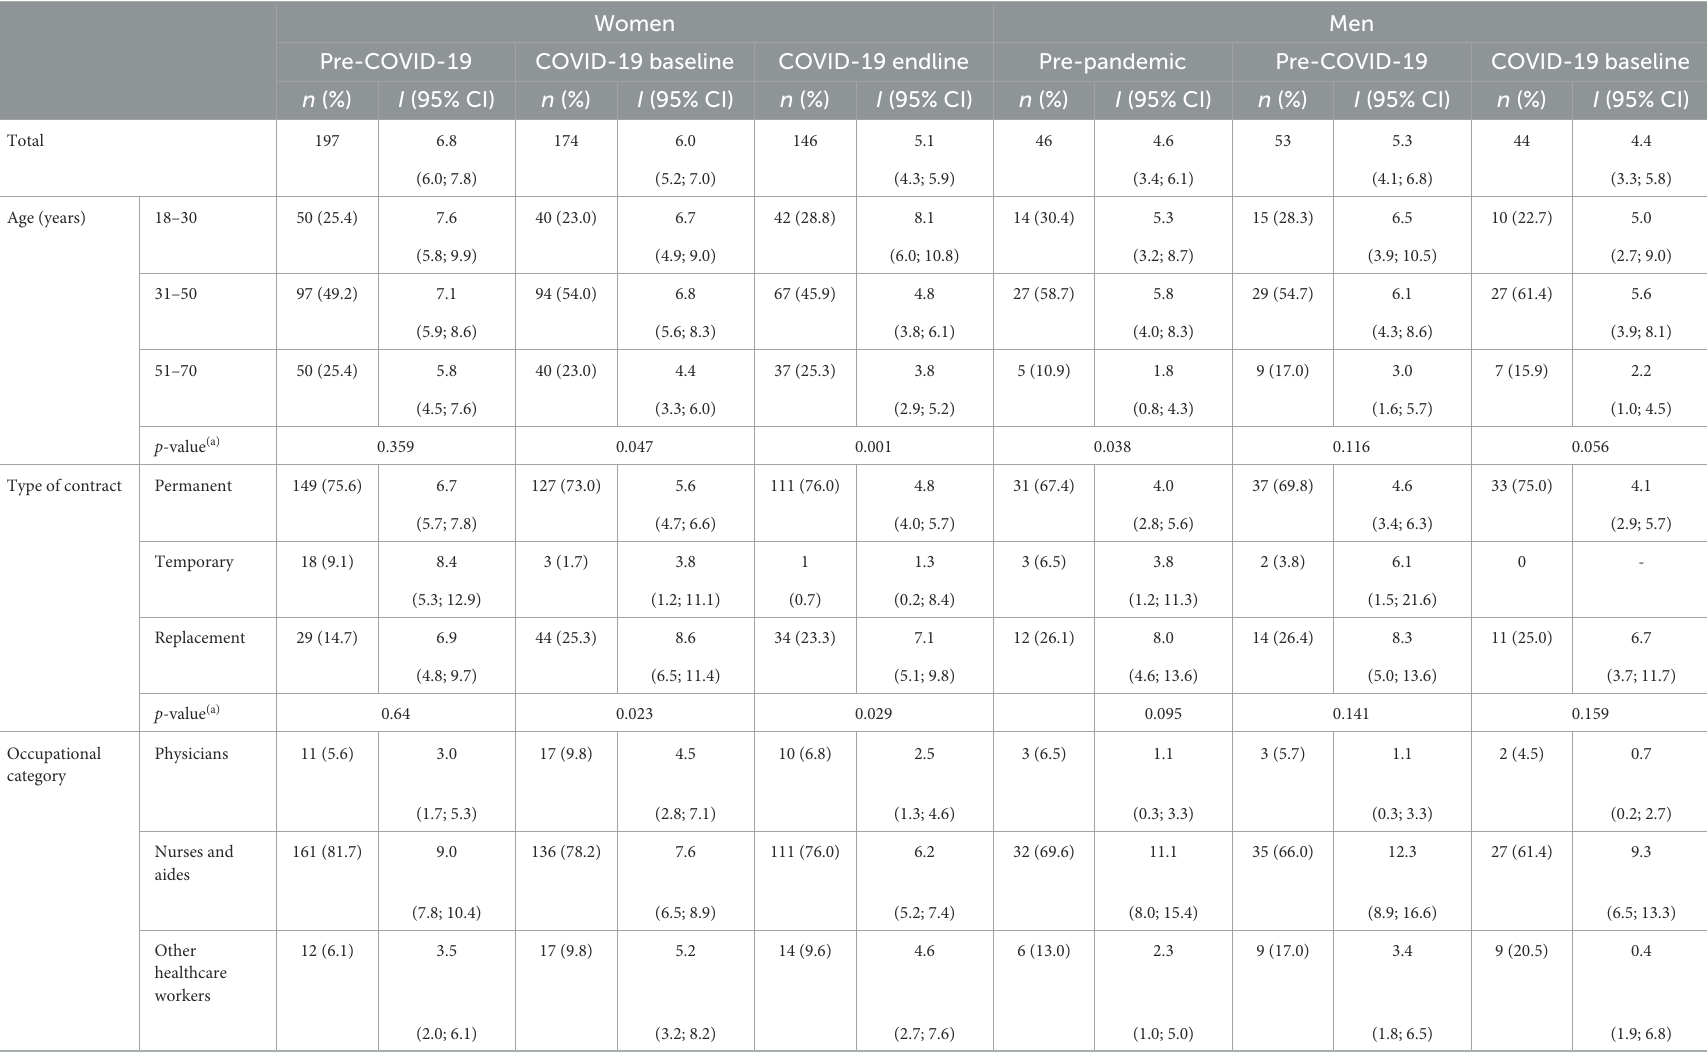
TABLE 3 Incident episodes ( n , %), cumulative incidence ( I ) and 95% confidence intervals (95% CI) of aggression according to sociodemographic and occupational variables, by time period ∗ and